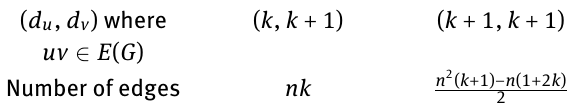
Table 2: The edge partition of the graph O R